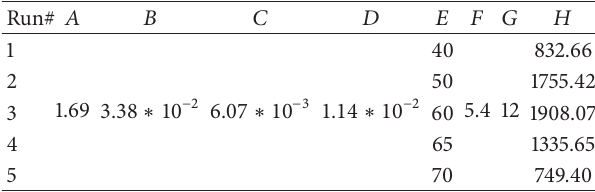
Figure 7: Effect of monomer concentration on apparent viscosity. Table 4: Reactions conditions with different